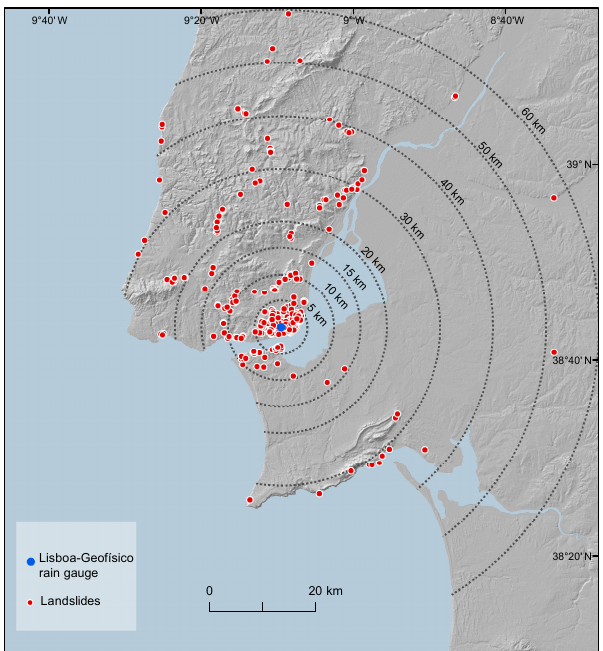
Figure 4. Distribution of landslides in the Lisbon region (1865/2010) and buffer distances from the reference rain